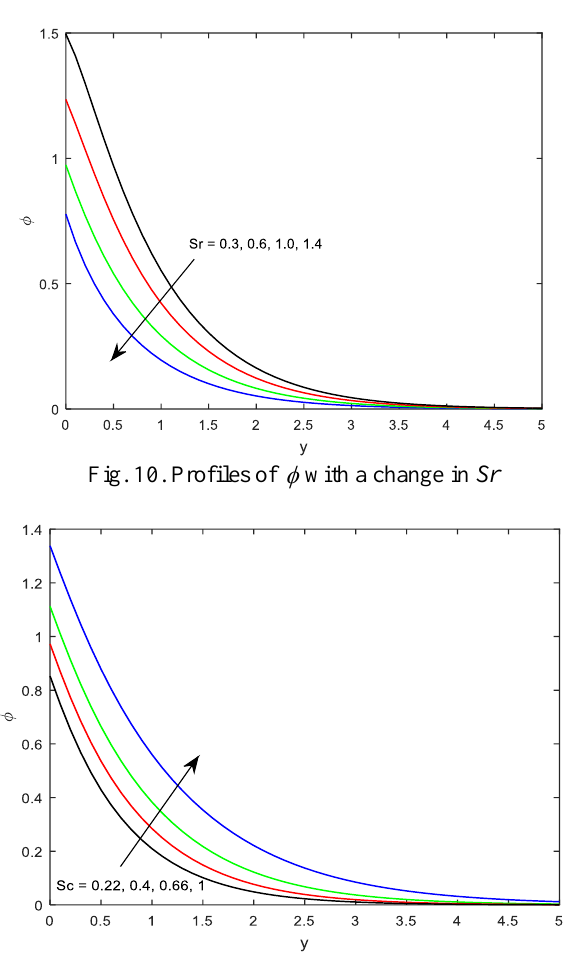
Fig. 11. Profiles of  with a change in S c